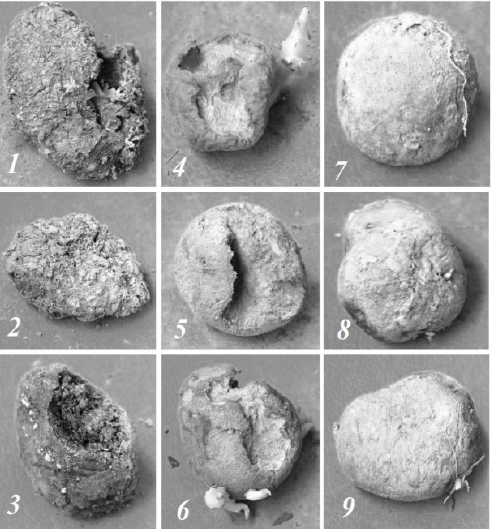
Figure 2. Examples of potato tubers: ( 1 – 3 ) dry rotted tubers; ( 4 – 6 ) tubers affected by rodents; ( 7 – 9 ) healthy tubers.